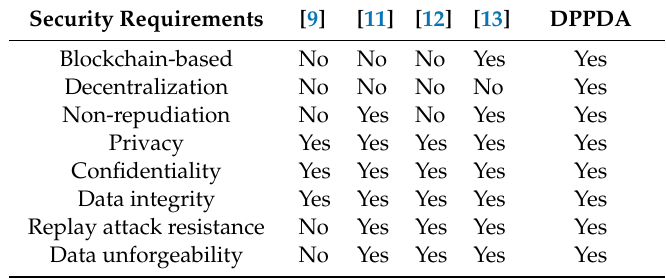
Table 2. Comparison between the proposed scheme and other related